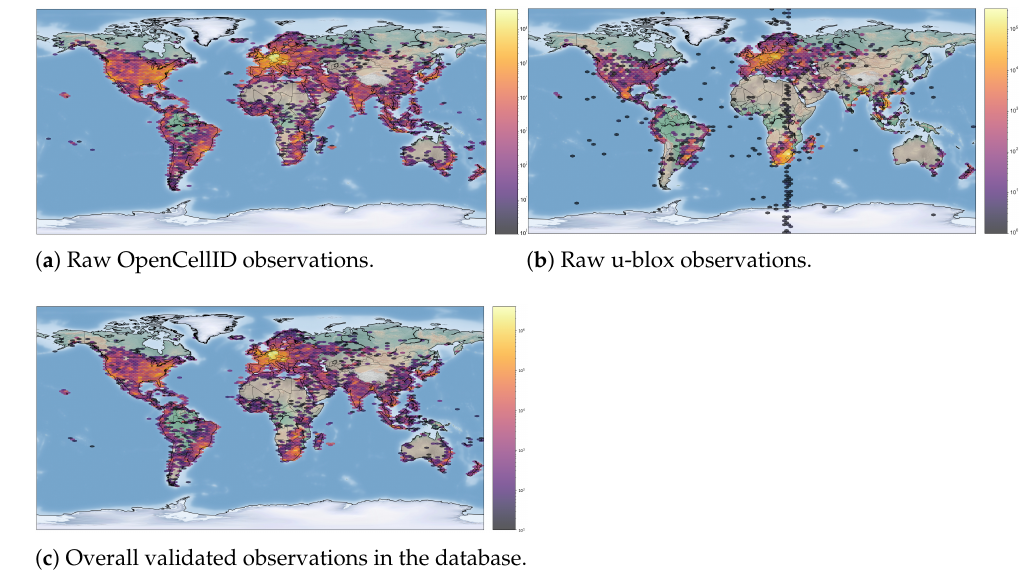
Figure 9. Observations spatially grouped by hexagons. Color = number of observations per